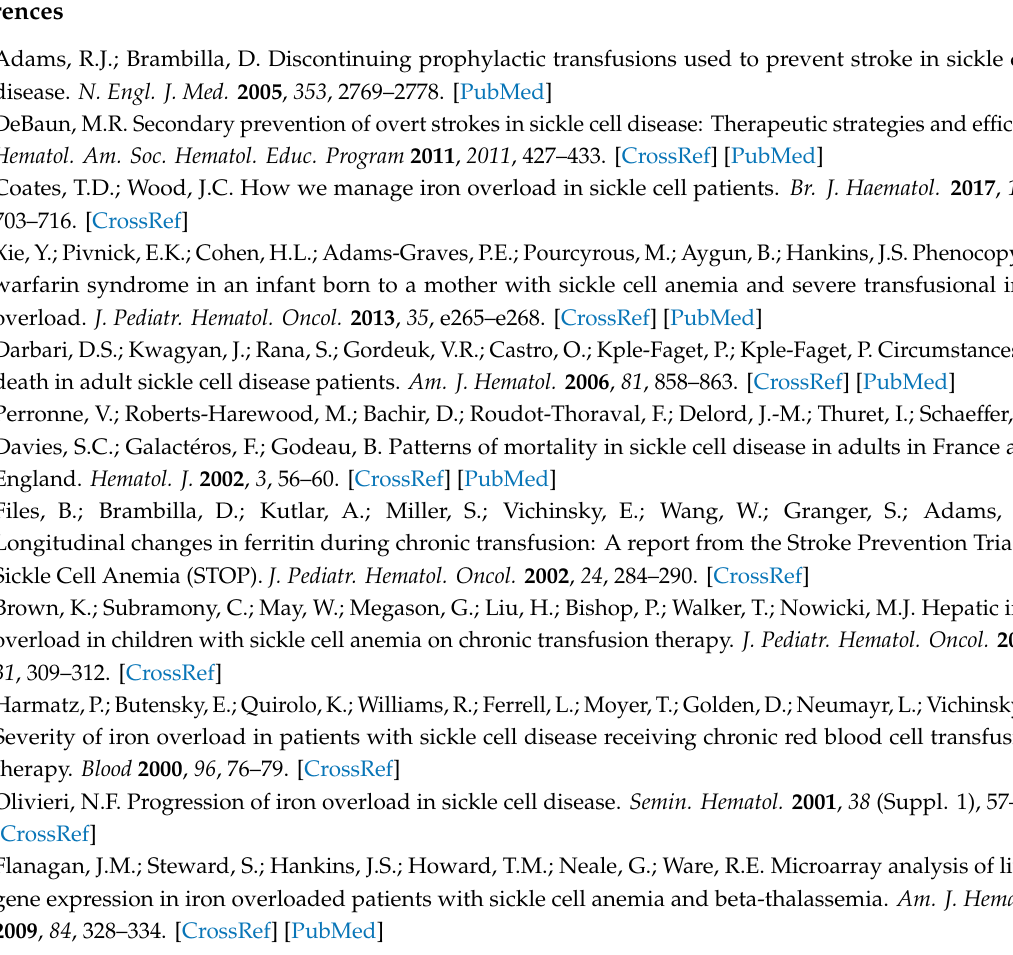
Figure S1: Serum ferritin according to GSTM1 genotype groups; Figure S2: Heart T2* according to GSTM1